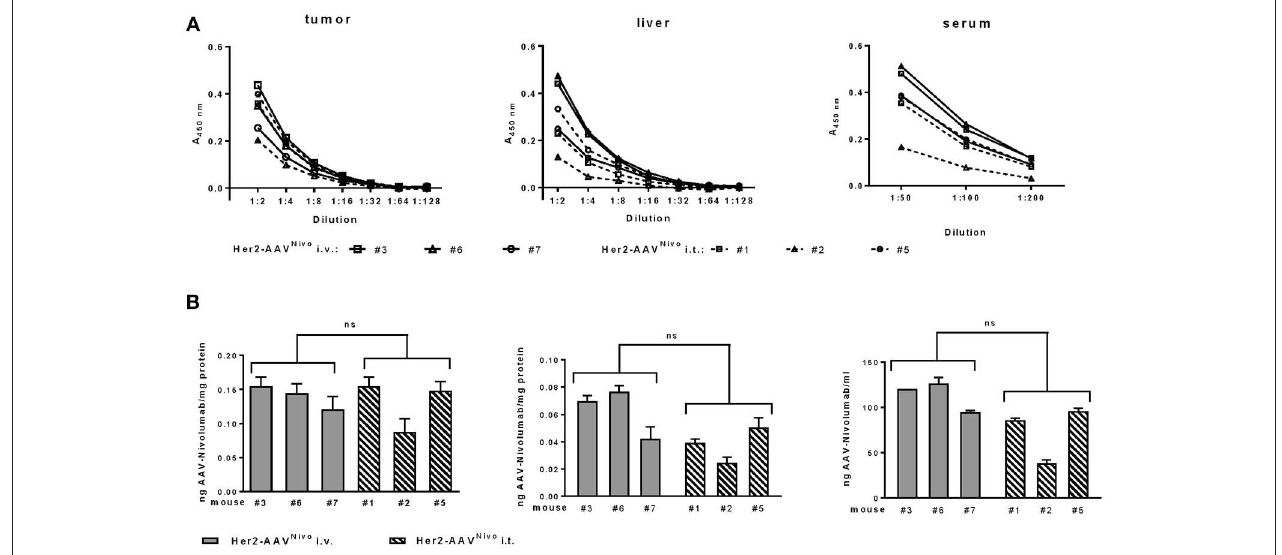
FIGURE 7 | Tumor-targeted delivery of nivolumab by Her2-AAV. RENCA-Her2/neu bearing BALB/c mice received two injections of Her2-AAV Nivo with 3.6 × 10 11 genome copies each, either intravenously ( A : black lines; B : gray bars) or intratumorally ( A : dashed lines; B : striped bars). Mice that received only PBS served as mock control. After 10 days organs were explanted and sera taken. Nivolumab present in tumor and liver organ lysates as well as in sera of the mice was quantified by sandwich ELISA using plates coated with recombinant PD-1 and an IgG-Fc-specific detection antibody. (A) Raw data obtained by ELISA. Values obtained from PBS-injected animals were subtracted from the ELISA signals of mice that had received AAV vectors. (B) Amounts of nivolumab present in tumor, liver, and serum. Values were normalized to the total protein yields for the organ lysates and calculated as ng/ml for the sera [tumor: n = 2 technical replicates per mouse, liver: n = 3 technical replicates per mouse; serum: n = 3 technical replicates per mouse; mean ± SD; ns, not significant by unpaired t -test ( n = 3 mice per organ and injection route; numbers mean individual